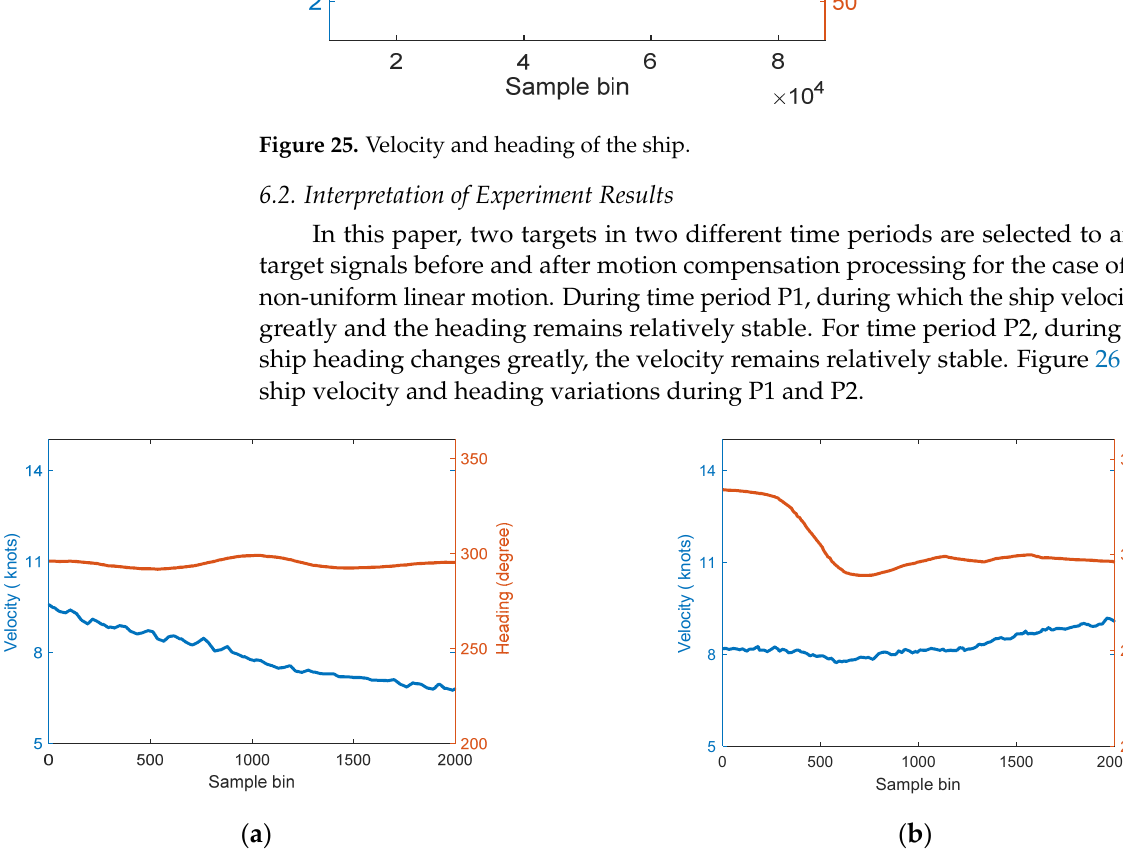
Figure 25. Velocity and heading of the ship.